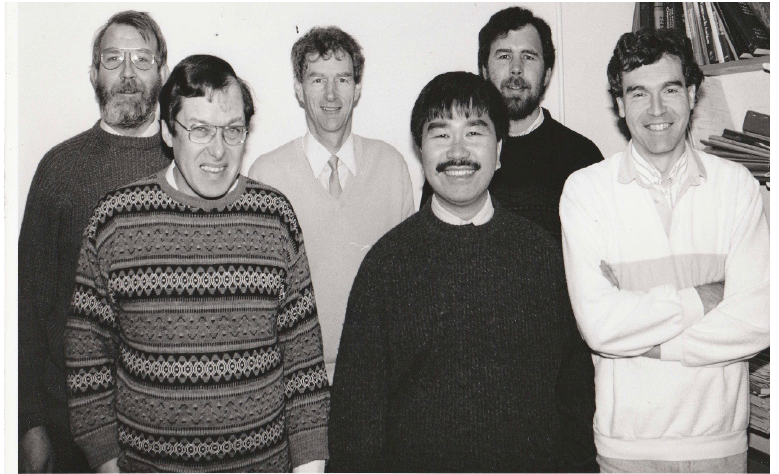
Figure 1. Front Row: Bob Sim, Alex Law, Duncan Campbell Back Row: Alister Dodds, Ken Reid, Tony Willis. In 1989, after one of the Immunochemistry Unit’s regular, and always successful, five year reviews of its research programmes, by the Medical Research Council.